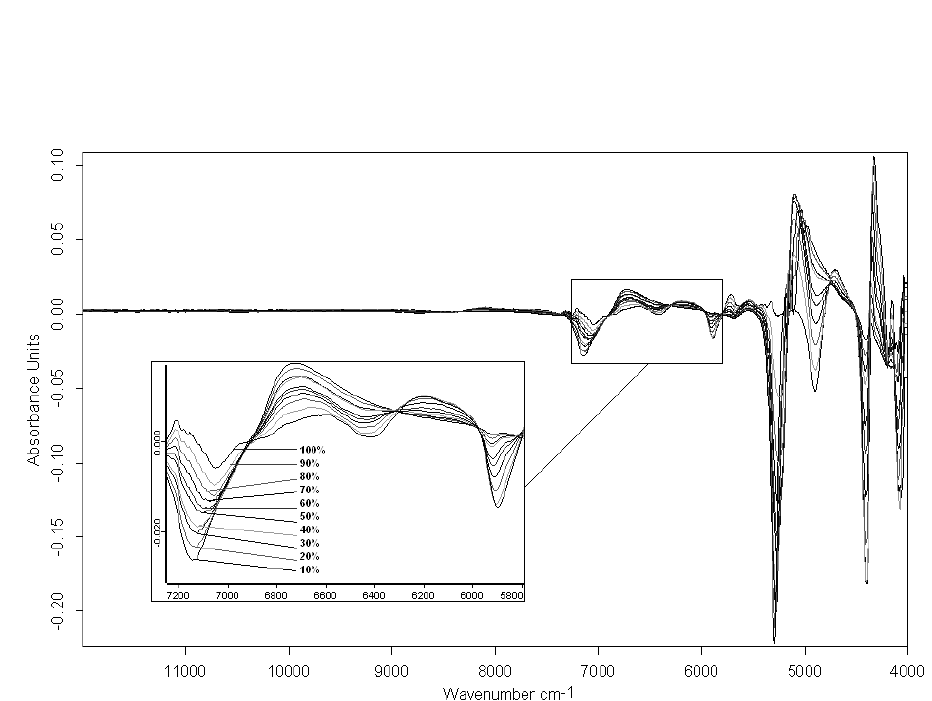
Fig. 5. Spectra of laboratory prepared samples under di®erent volume concentrations of DEG (preprocessed by Savitzky – Golay ¯rst derivative and vector